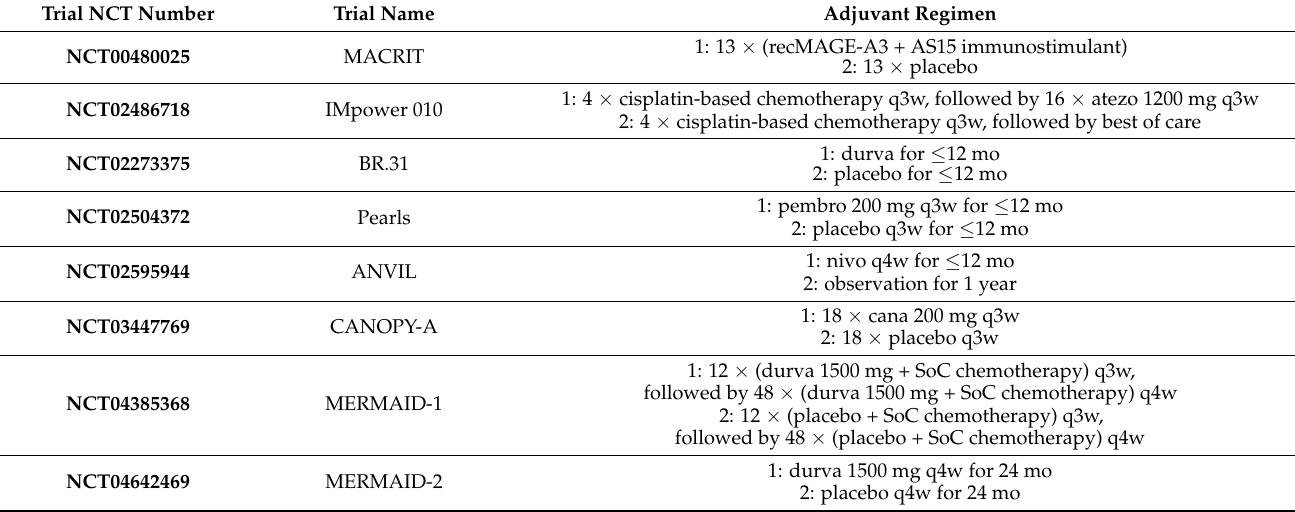
Table 6. Treatment regimens of selected clinical trials that included adjuvant immunotherapy in resected